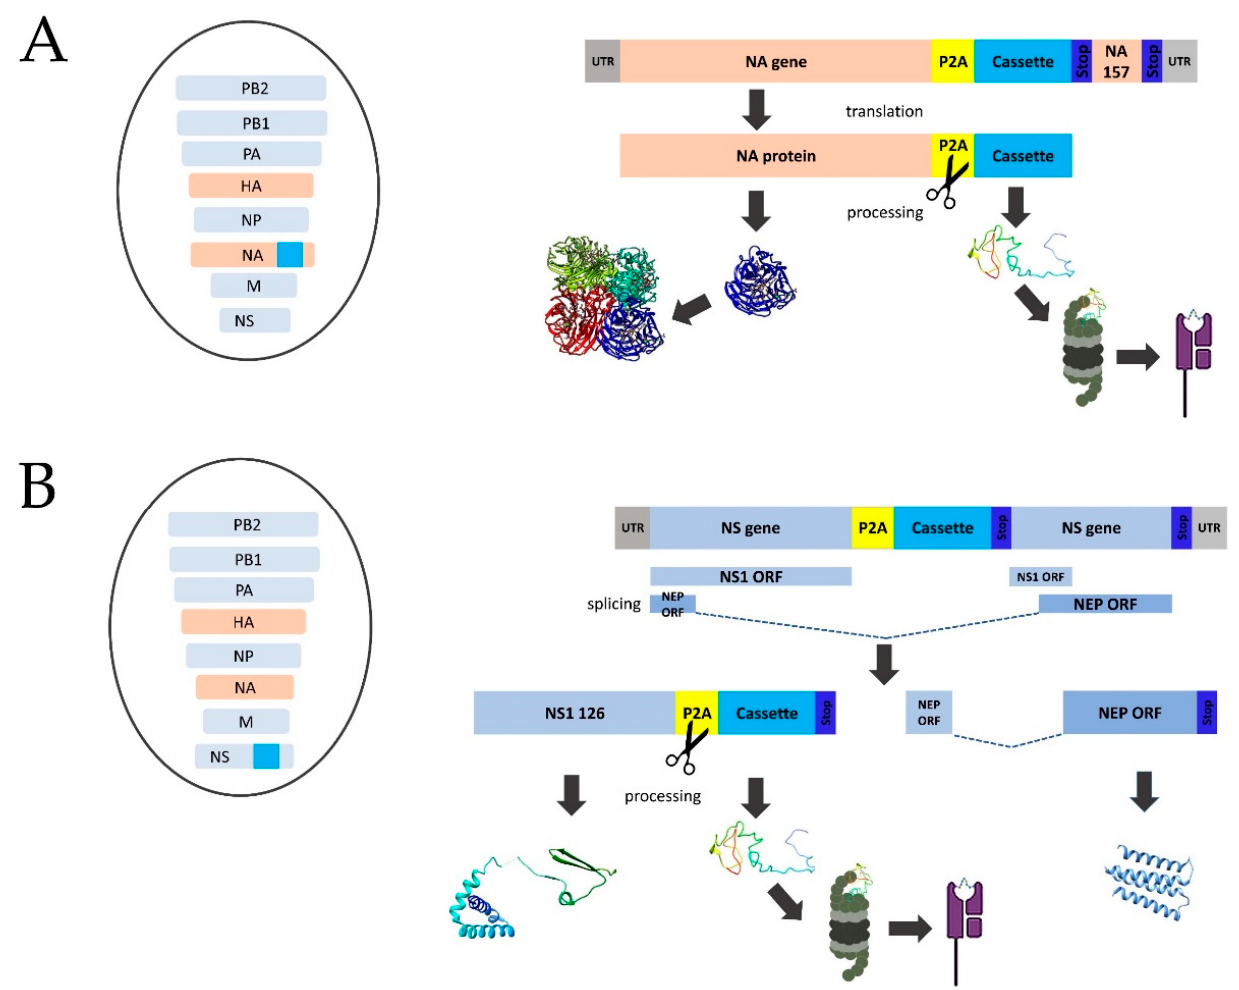
Figure 2. The generation of recombinant LAIV viruses expressing SARS-CoV-2 T-cell cassettes. ( A ) Schematic representation of modified NA gene of influenza virus. ( B ) Schematic representation of modified NS gene of influenza virus. The left panel represents the genome compositions of the rescued recombinant influenza viruses with Len/17 genes shown in light blue and H7N9 HA and NA genes shown in ochre. The SARS-CoV-2 polyepitope cassette inserts are shown in dark blue. P2A: a self-cleavage site (GSGATNFSLLKQAGDVEENPG ↓ P).